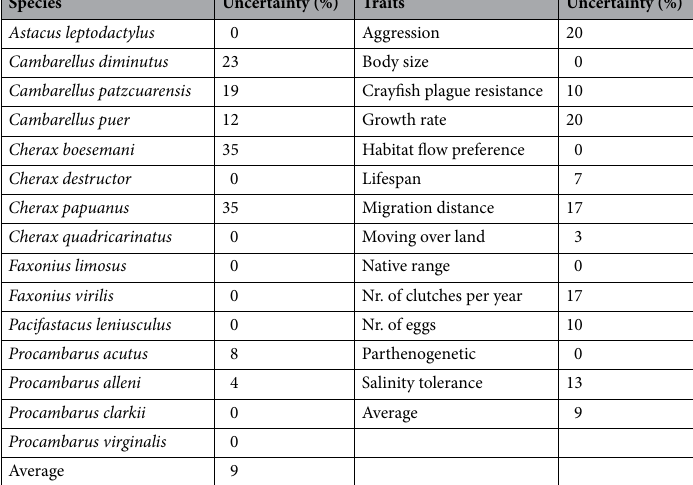
Table 3. Uncertainty calculated in percentage for each functional trait and crayfish